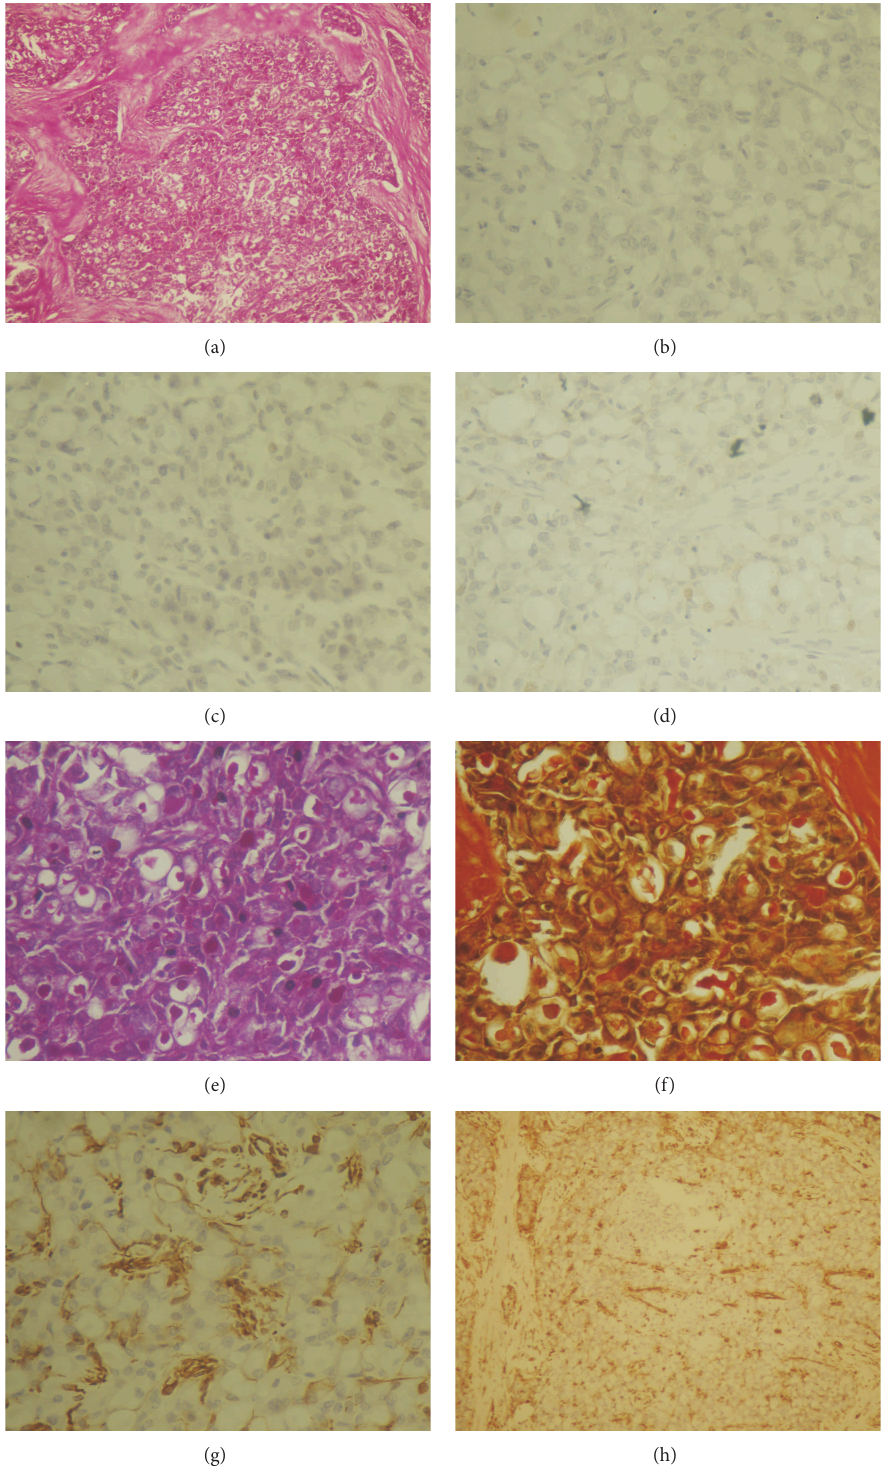
Figure 1: (a) Scanner view of hematoxylin and eosin stained slide. (b), (c), (d) Immunohistochemistry for estrogen receptor (b), progesterone receptor (c), and HER 2neu (d). Special stains immunohistochemistry showing PAS staining (e), mucicarmine (f), and vimentin at 400x (g) and at 100x